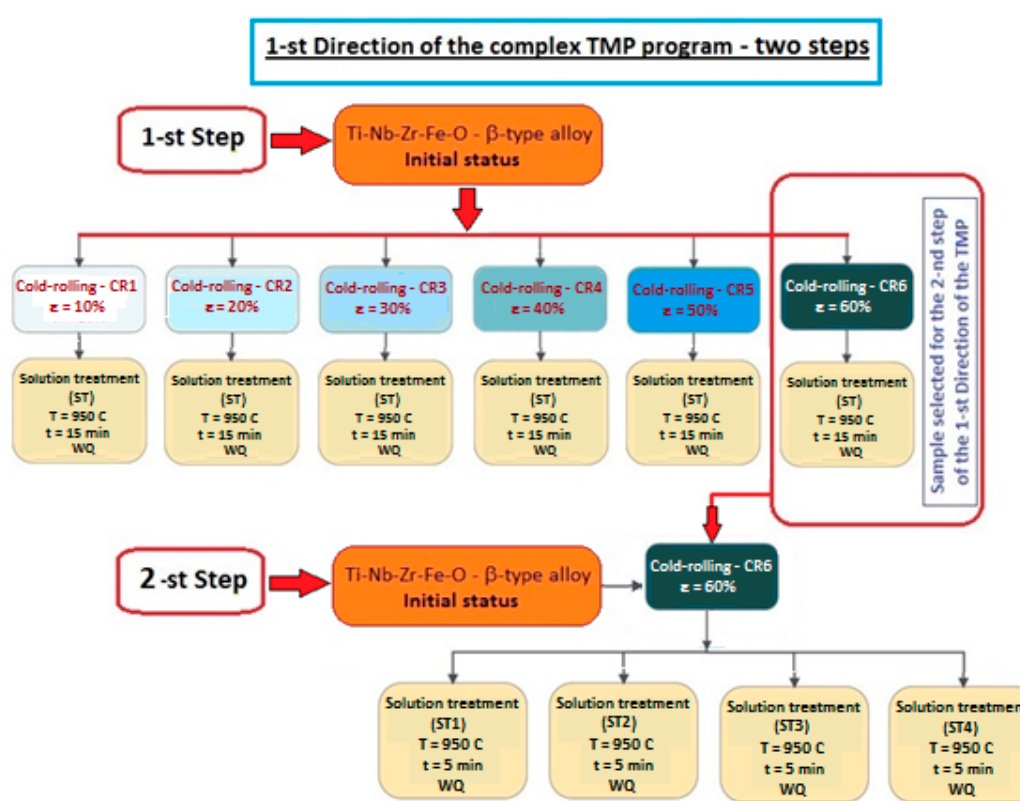
Figure 2. The 1st Direction of the complex TMP Program applied to the studied β -type Ti-Nb-Zr-Fe-O alloy.